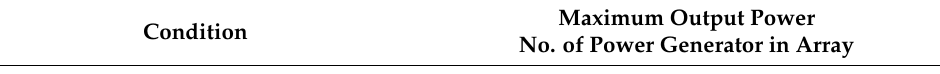
Table 3. Summary of output performance of hammer-impact-driven power generator with various wind conditions.